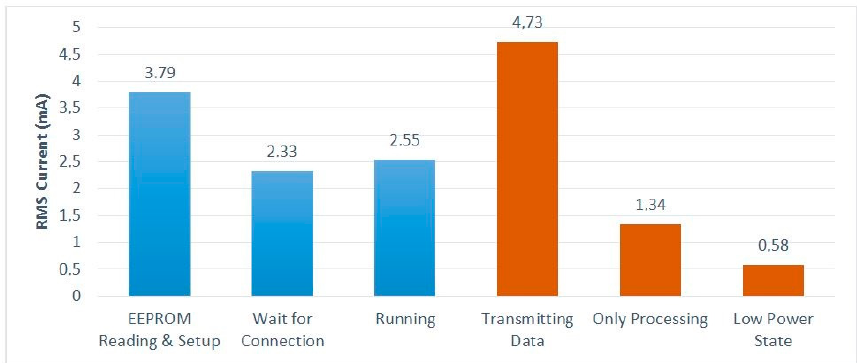
Figure 6. Power consumption of each one of the operation modes and main tasks.